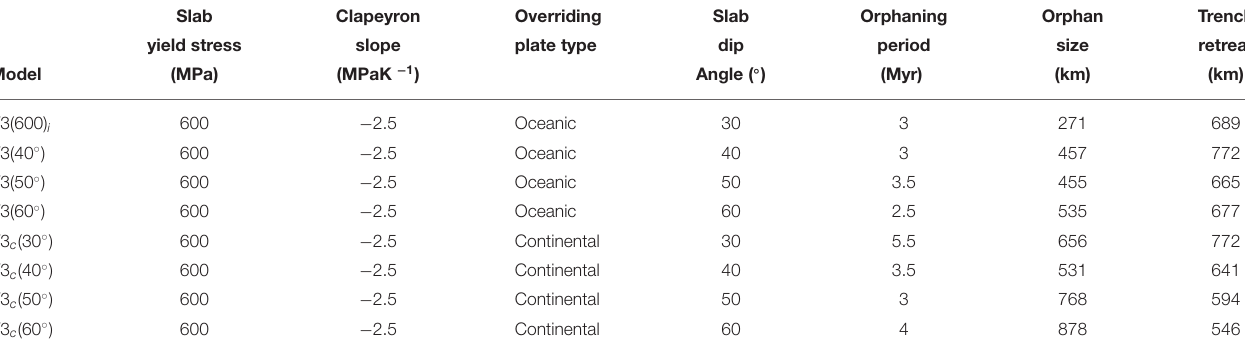
TABLE 4 | Orphan sizes, orphaning periods, and their associated trench retreat compared across all orphan variants in intra-oceanic and continent-ocean subductions. Slab Clapeyron Overriding Slab Orphaning Orphan Trench yield stress slope plate type dip period size retreat